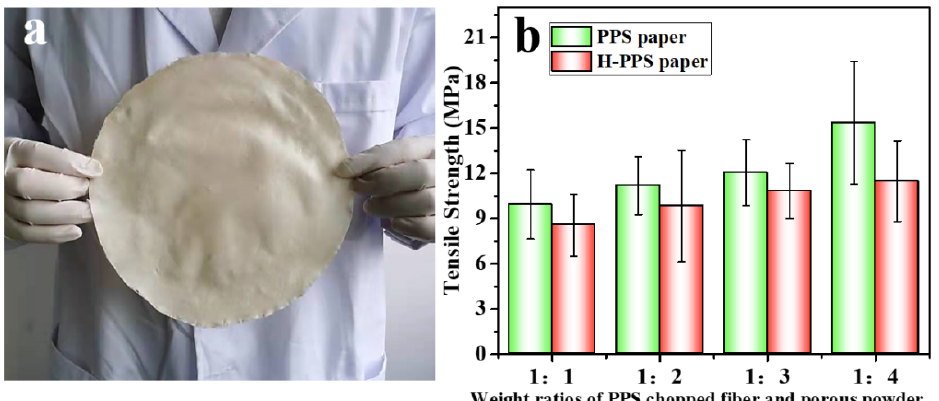
Figure 2. ( a ) Digital images of prepared large-sized PPS paper; ( b ) tensile strength of PPS and HPPS papers prepared with different component contents.